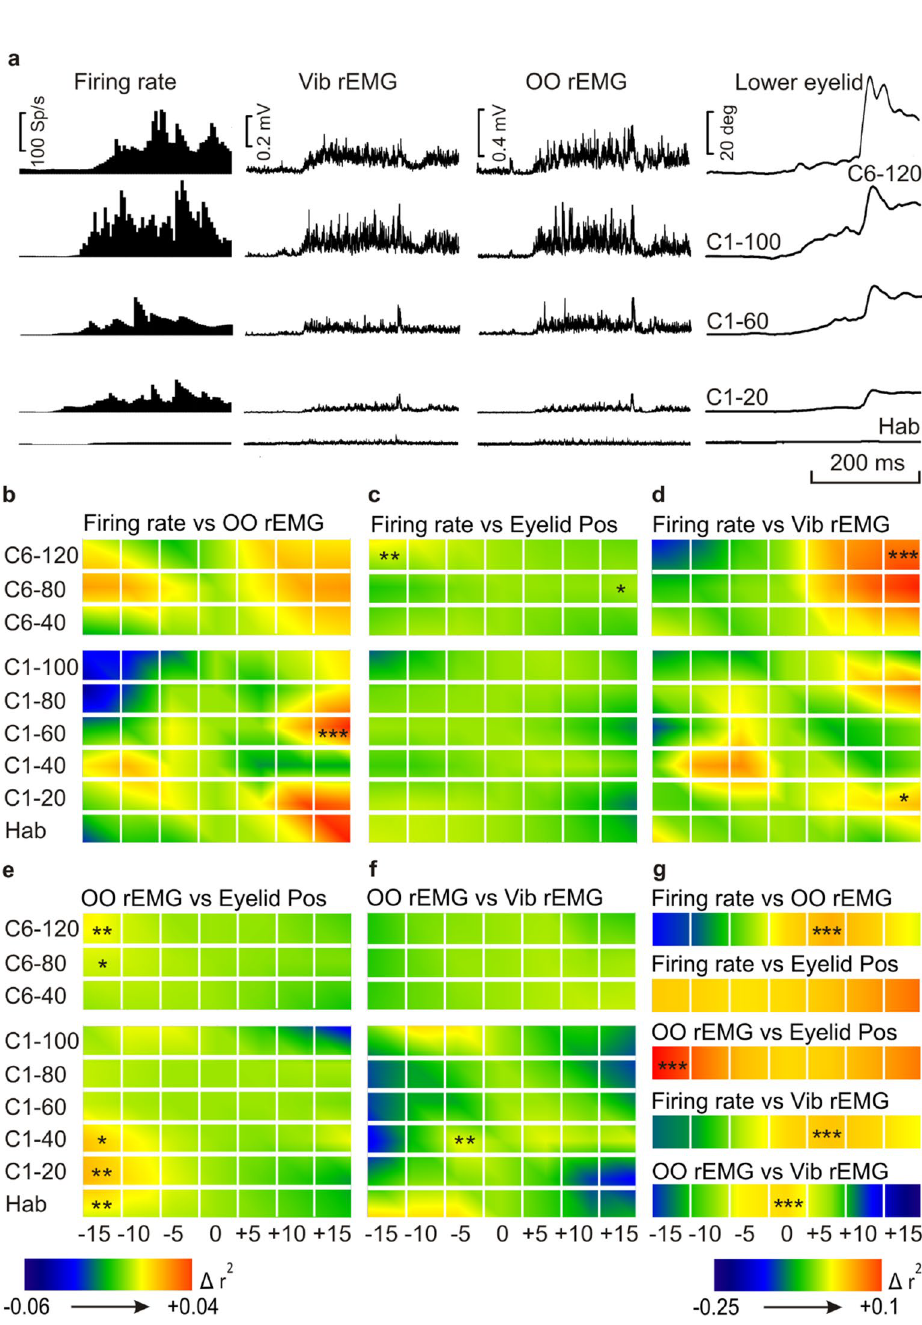
Figure 6. Timing correlation between MC neuron firing rate, OO rEMG, Vib rEMG, and lower-eyelid position, during eyeblink and vibrissae conditioning with a trace paradigm, and during an air-puff-evoked reflex response. ( a ) A raster representation of firing rate, Vib rEMG, OO rEMG, and lower-eyelid position corresponding to the average of 20 habituation (Hab) and three groups of 20 trials corresponding to the first conditioning session (C1–20, C1–60, and C1–100), and the average of the last 40 trials of the sixth conditioning session (C6–120). ( b – f ) Colorimetric representation of the timing correlation between MC neuron firing rate vs. OO rEMG ( b ), MC neuron firing rate vs. eyelid position ( c ), MC neuron firing rate vs. Vib rEMG ( d ), OO rEMG vs. eyelid position ( e ), and OO rEMG vs. Vib rEMG ( f ), calculated as shown in Fig. 5b. The color code of normalized r 2 values is represented at the bottom left. Illustrated data correspond to the average of n = 13 animals for Hab and C1 and n = 11 for C6. Asterisks represent significant differences between any of the seven averaged normalized r 2 values, and are allocated over the higher ones, * P < 0.05; ** P < 0.01; *** P < 0.001. One way ANOVA. ( g ) Colorimetric representation of the timing correlation between MC neuron firing rate vs. OO rEMG, MC neuron firing rate vs. Vib rEMG, MC neuron firing rate vs. eyelid position, OO rEMG vs. eyelid position, and OO rEMG vs. Vib rEMG during a reflexively evoked blink. Data were calculated as shown in Fig. 5b and correspond to n = 13 animals. Asterisks represent significant differences between any of the seven averaged normalized r 2 values, corresponding to the − 15, − 10, − 5, 0, + 5, + 10, and + 15 ms shifted recordings compared, for the averaged group of trials, and are allocated over the higher ones, * P < 0.05; ** P < 0.01; *** P <